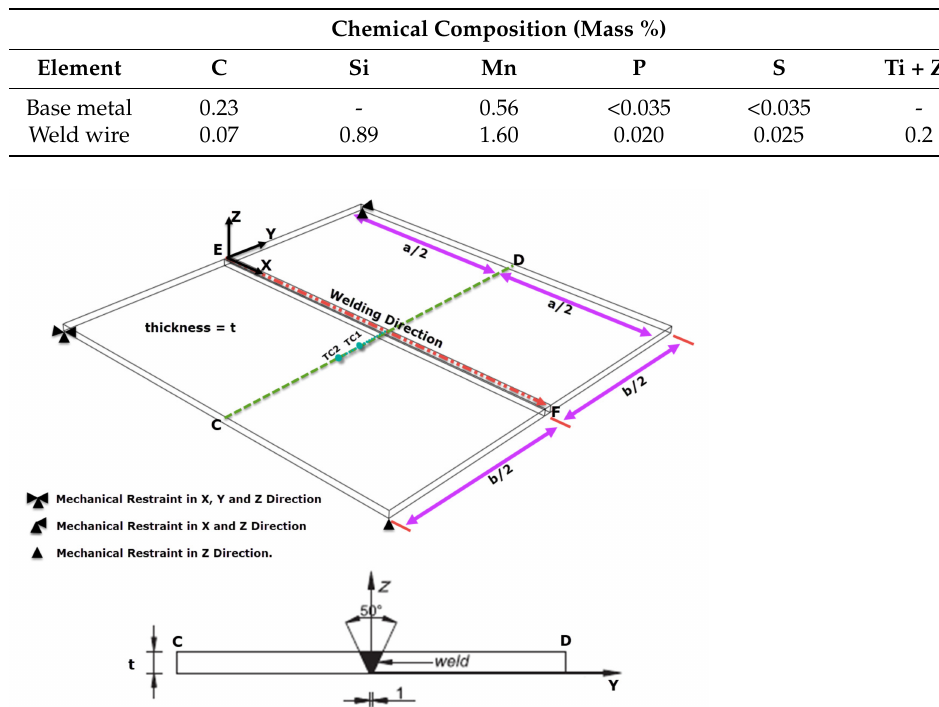
Table 1. Chemical composition of SM400A base metal [31] and JIS Z3312 YGW11 wire metal.